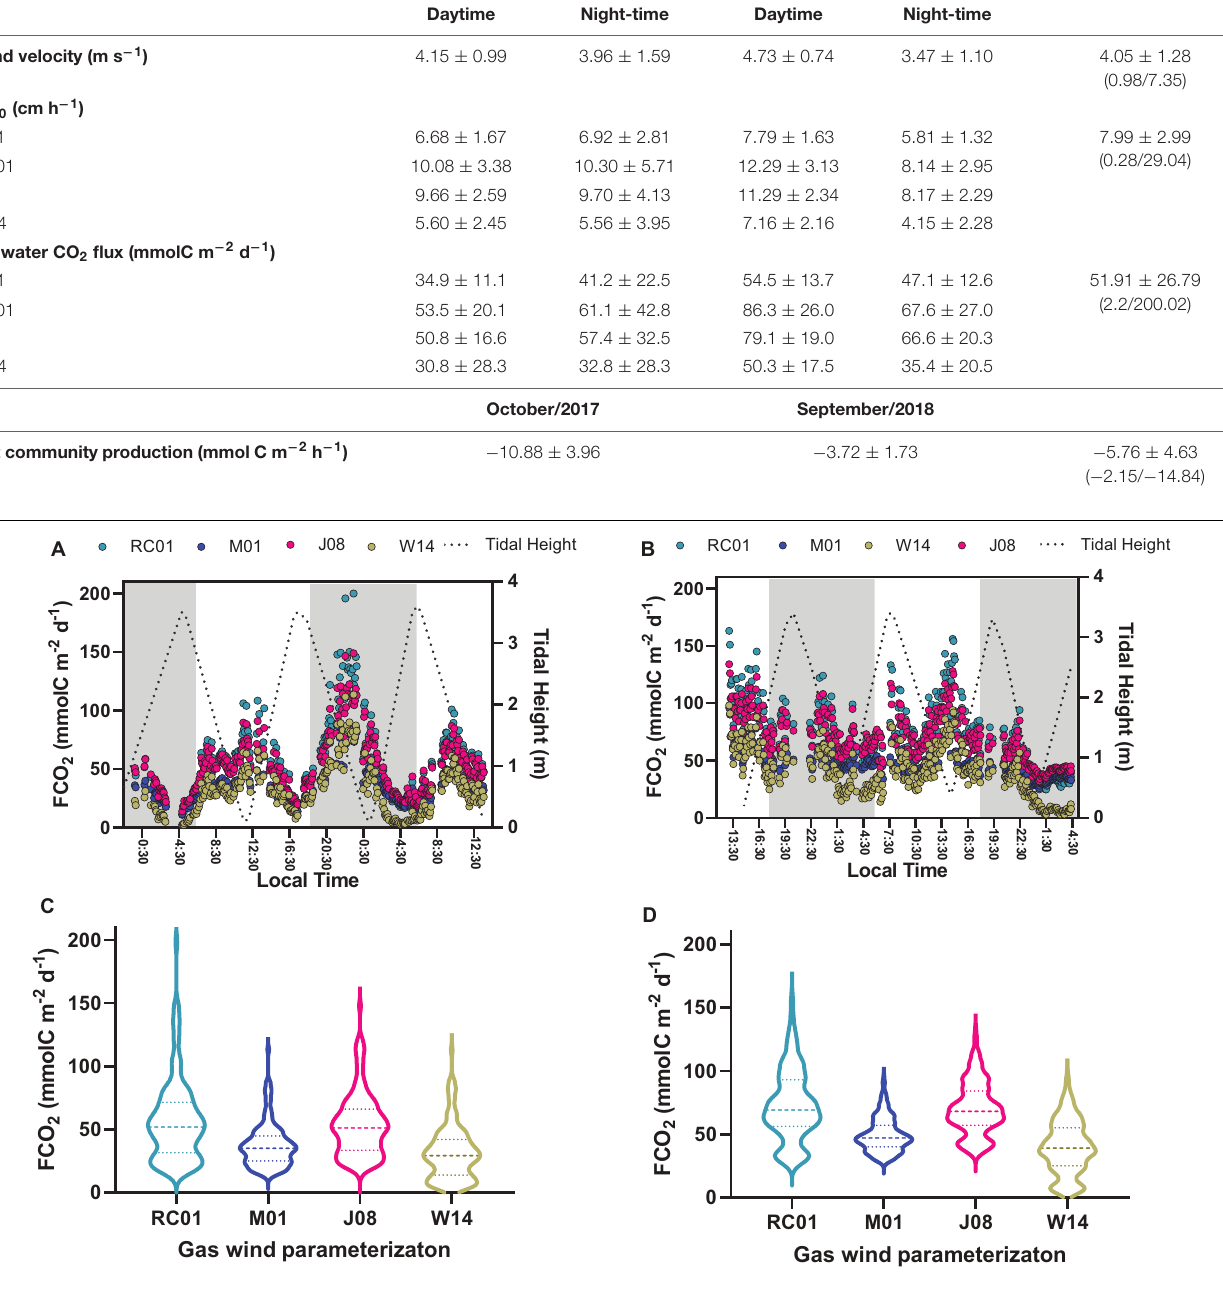
FIGURE 6 | Graphs (A,B) represent the time-series observations of FCO 2 calculated with different gas transfer velocities parameterizations. Graphs (C,D) represent violin plots, showing the median, and 25 and 75 percentiles of FCO 2 calculated with different gas transfer velocities parameterizations. Graphs on the left side represent Oct-2017; graphs on the right side represent